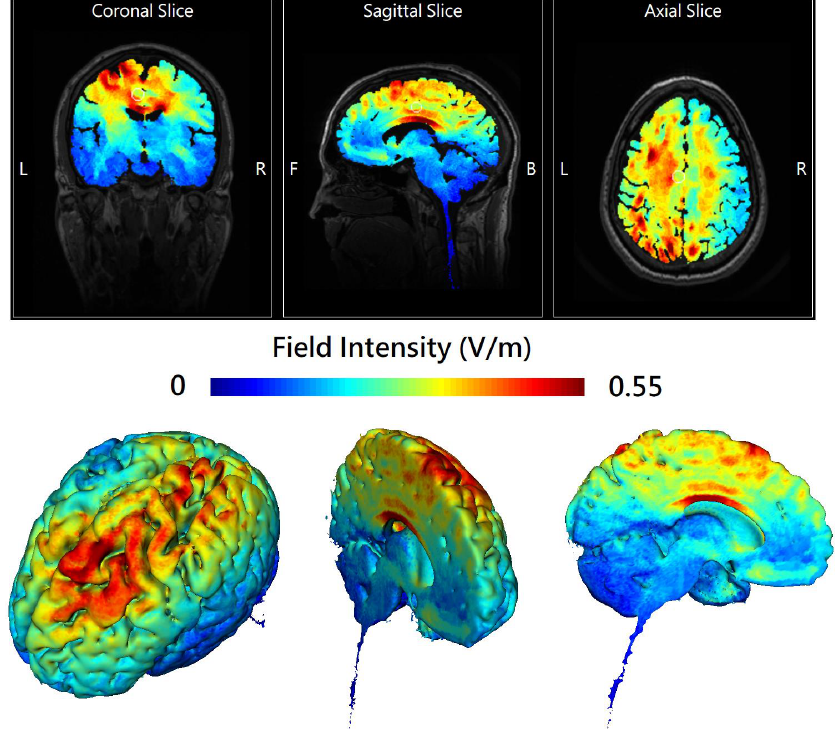
Figure 1. The 2D ( upper panel) and 3D ( lower panel) representation of electric field simulation of left-hemispheric frontoparietal theta in-phase transcranial alternating current stimulation (theta-tACS) by HD-Explore ® (Soterix Medical, New York, NY, USA), which utilizes a finite element model of brain current flow based on an MRI derived MNI-152 standard brain template. The colorbar indicates the intensity of electrical field (V/m). In the upper panel, the center of the white circle represents the stereotaxic coordinate (x − 11, y − 18, z + 40) where the field intensity is 0.28 V/m.